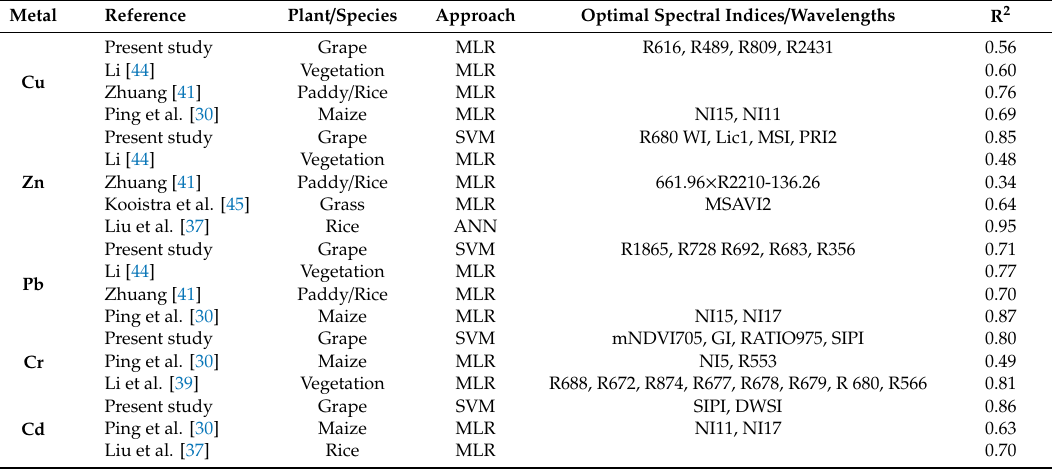
Table 5. Comparison results of the best models presented in this study and other similar studies in relation to the estimation of heavy metal contents in plant species using field-based